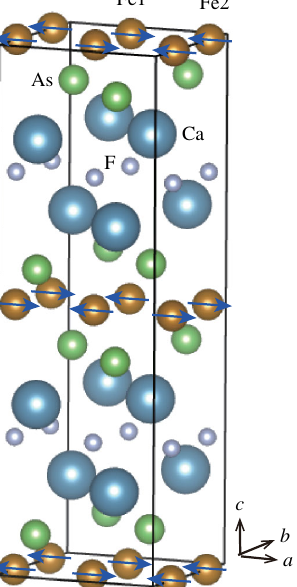
FIG. 1. Crystal and magnetic structure of CaFeAsF. The a , b , and c directions of the orthorhombic Cmma cell are indicated. The black frame indicates the magnetic cell with the doubled c dimension, and the arrows indicate the Fe moment direction. Fe1 and Fe2 label magnetic sublattices used to calculate partial density of states in Fig. 7.